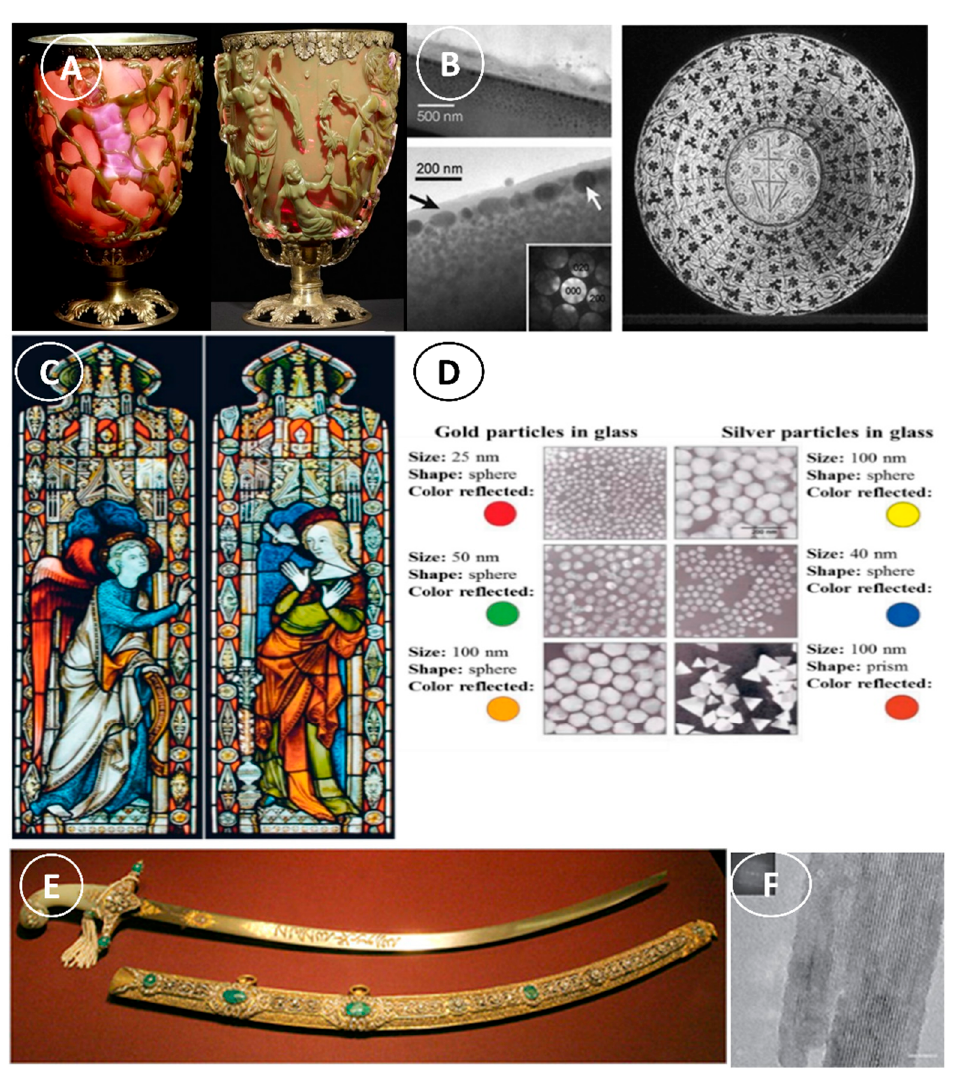
Figure 4. Examples for some handmade nanomaterials used in medieval times. ( A ) The Lycurgus cup is brilliant red when light passes through the glass that contains Au-Ag NP alloy (The Trustees of the British Museum/Art Resource, NY). ( B ) Ag NPs in ancient ceramic plates [35]. © Wiley, 2004 ( C ) Nanoparticles in medieval church windows [36]. © MDPI, 2000 ( D ) Transmission electron microscopy (TEM) images of the Au and Ag NPs used in colored window glasses in medieval churches. ( E ) Saber made of Damascus steel (photograph by Tina Fineberg for The New York Times); ( F ) TEM image of CNTs in a Damascus Saber after dissolution in hydrochloric acid, showing some cementite nanowires encapsulated by carbon nanotubes (scale bar, 5 nm) [34]. © Nature,